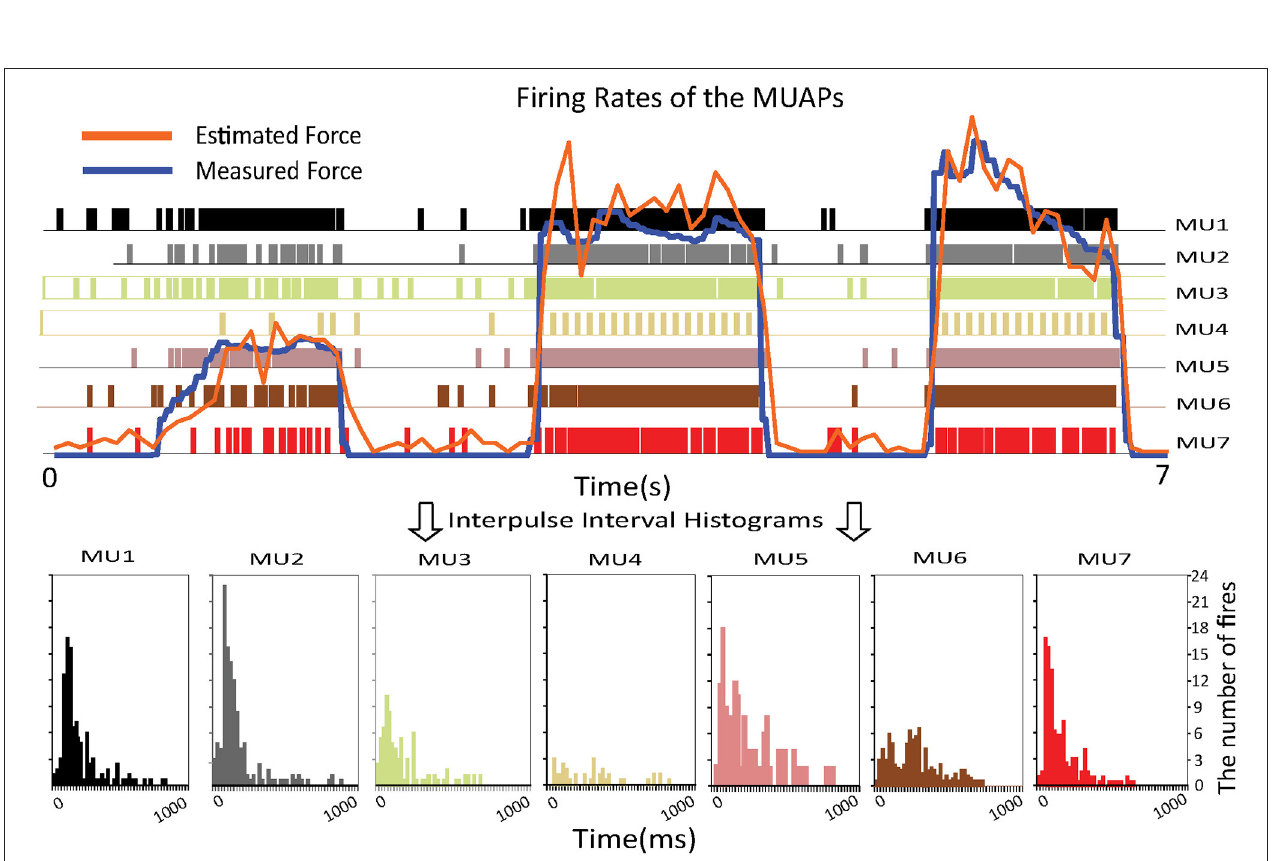
FIGURE 5 | Relationship between the firing rates of the MUAPs and the muscle force (Top) and interpulse interval histograms of the MUs (Bottom) .